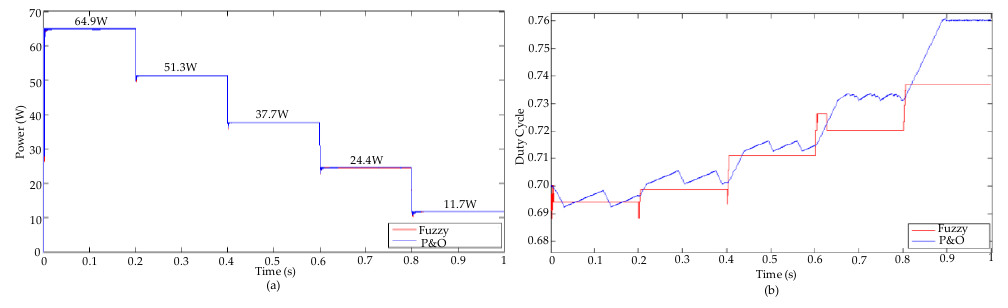
signal shown in Figure 18b was used, with decreases in temperature between 100 °C and 0 °C.